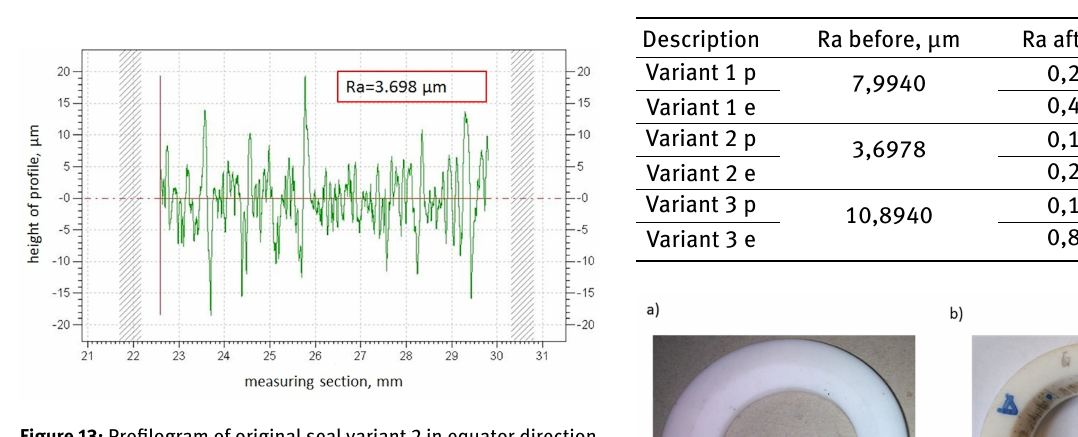
Table 1: Seal roughness (Ra parameter) before and after tests;